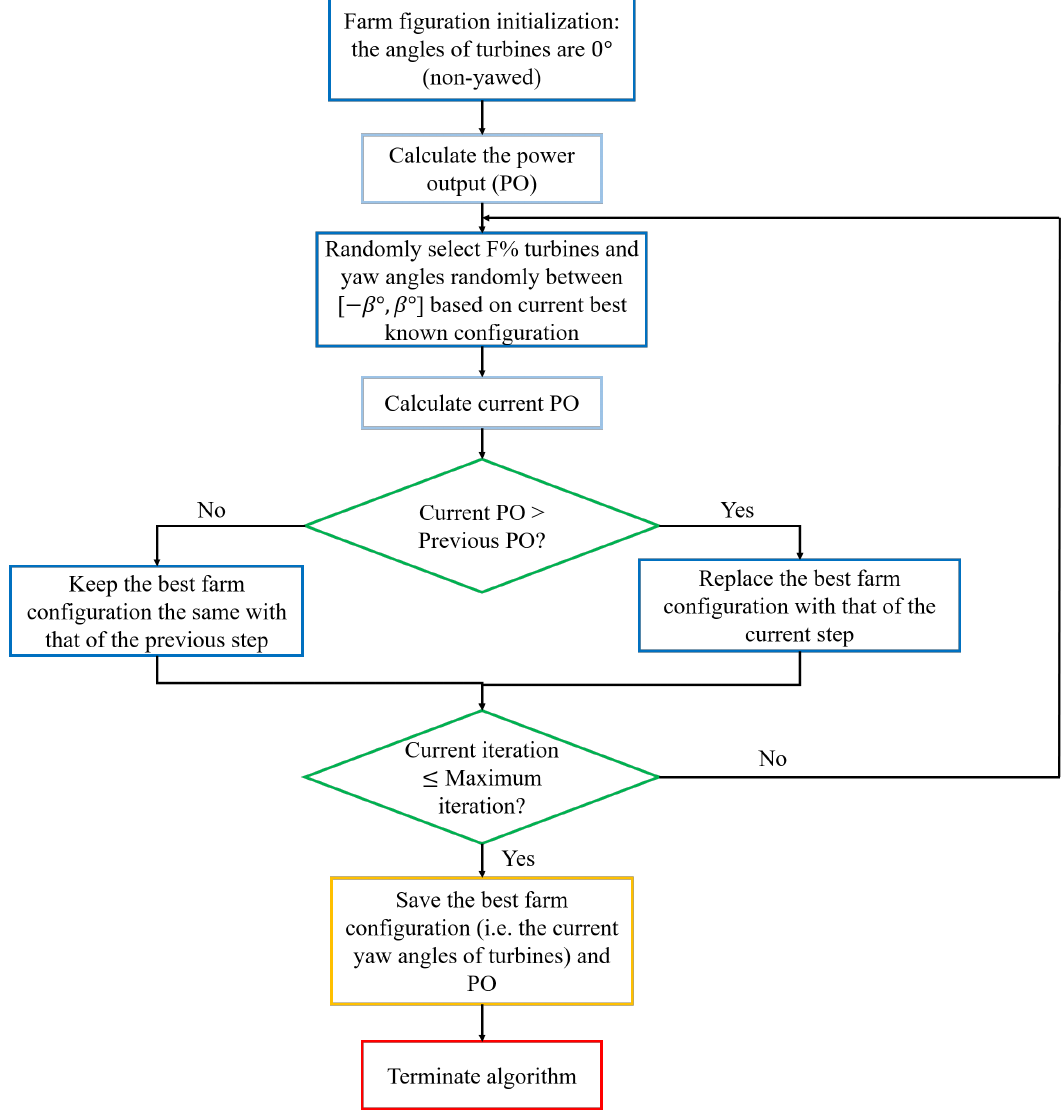
Figure 3. Proposed random search algorithm. Note that power output is abbreviated as